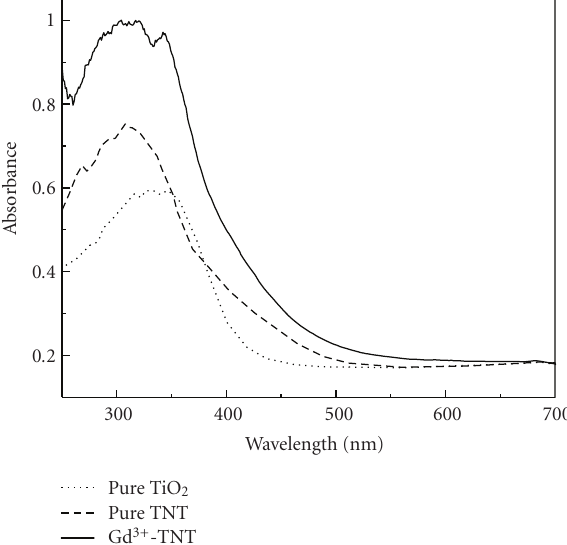
Figure 3: UV-Vis absorption spectra obtained from (1) pure TiO 2 ; (2) Pure TNT; (3) 5% Gd 3+ -TNT.